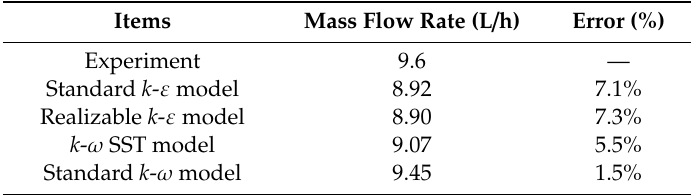
Table 1. Mass flow rate calculated by di ff erent turbulence models.